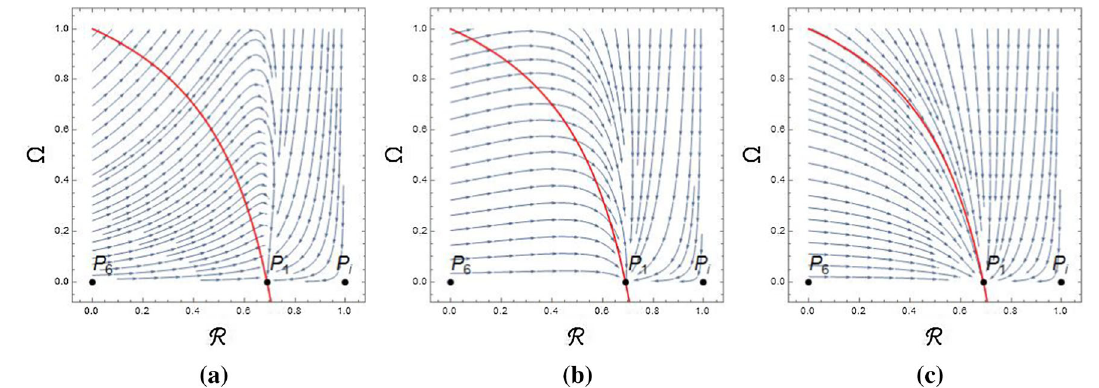
that this can correspond to either cases (a) – (c) for the parameter choice β = 1 , 0 , − 1. The red curve corresponds to the boundary between the attracting part (right side of the curve) and repelling part (left side of the curve) of the submanifold. The fixed points P 1 , P 6 and P i lie on this